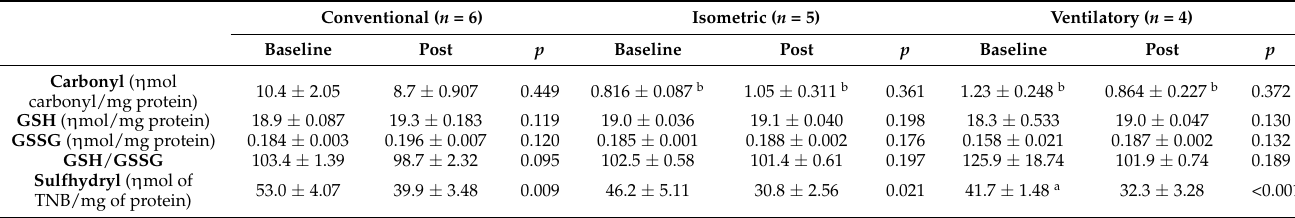
Table 3. Oxidative stress analysis.